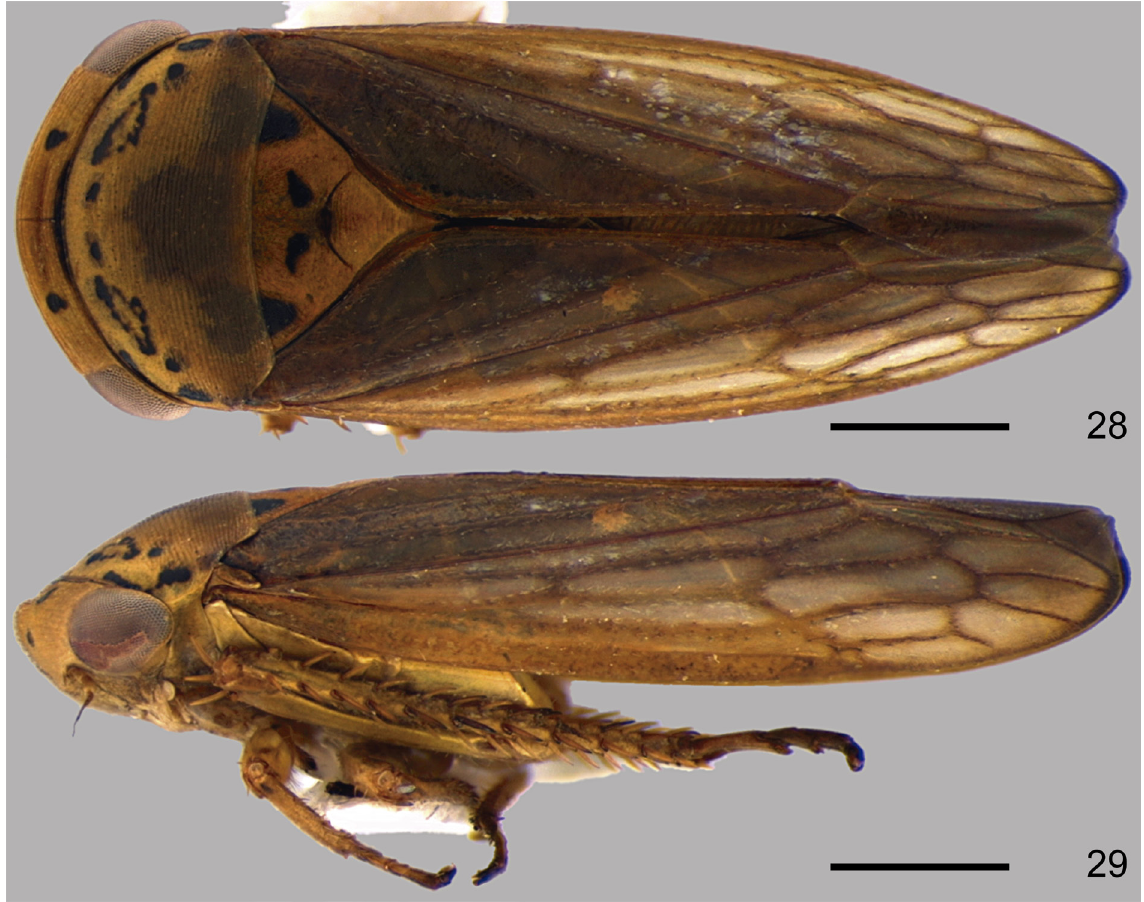
Figs 28–29. Guaricicana borgesi gen. et sp. nov., holotype, ♂ (DZUP 215374). 28 . Dorsal habitus. 29 . Lateral habitus. Scale bars = 1